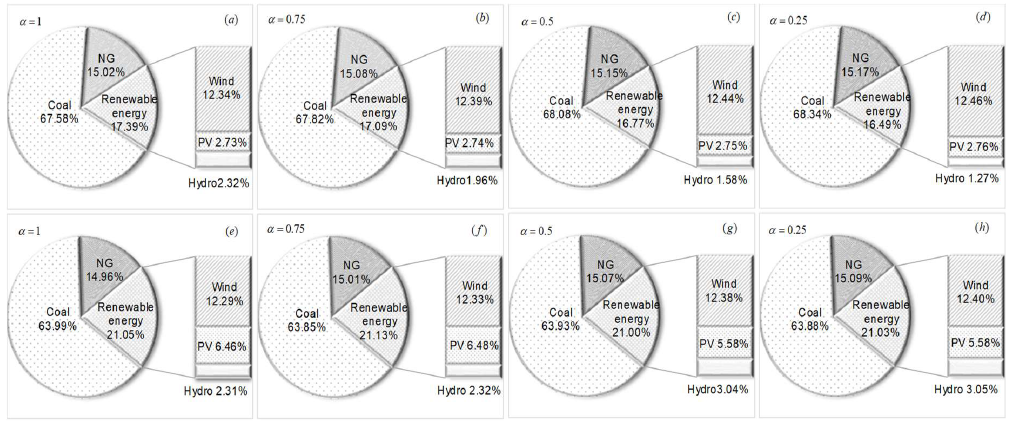
Figure 7. Comparison of power-generation patterns. Note. ( a – d ): σ = 15%; ( e – h ): σ = 20%.